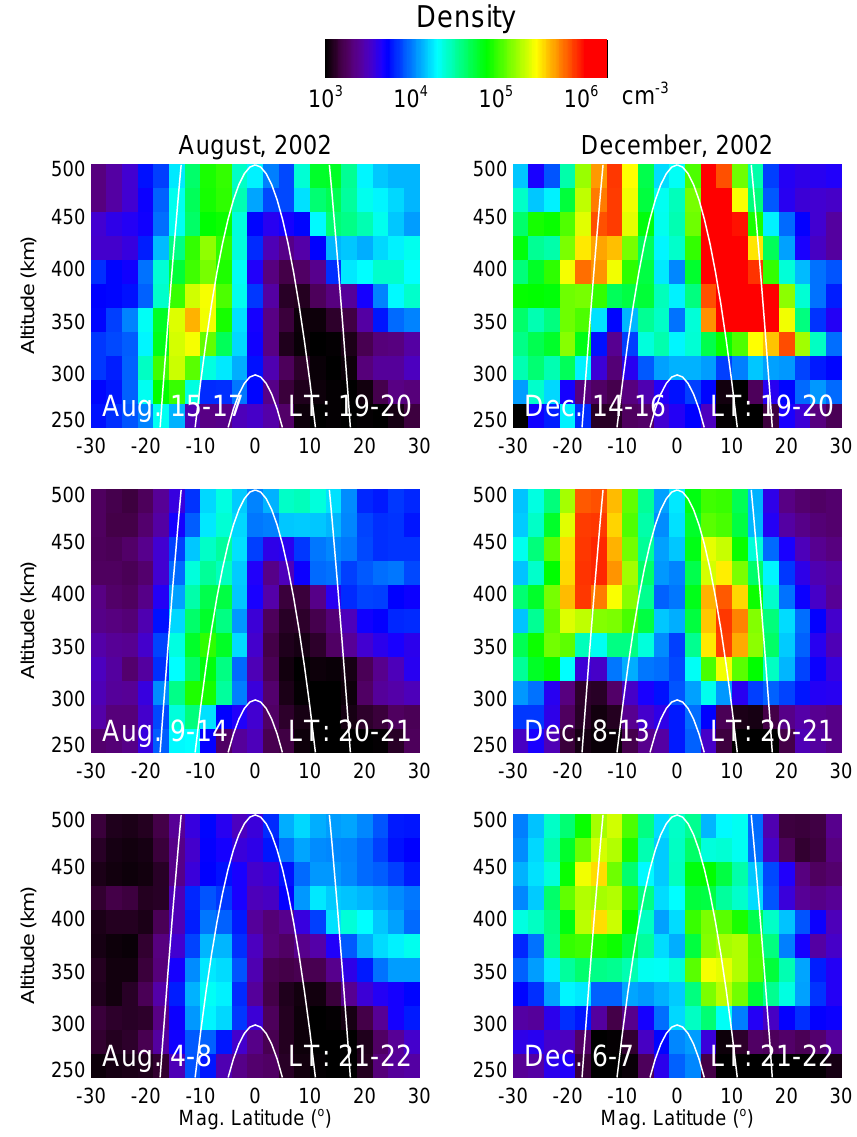
Fig. 2. Average electron density profiles deduced from the GUVI limb retrievals in the Atlantic sector during 4–17 August and 6–16 Decem- ber 2002. The dipole field lines at the apex heights of 300km, 500km, and 900km are shown by white curves.